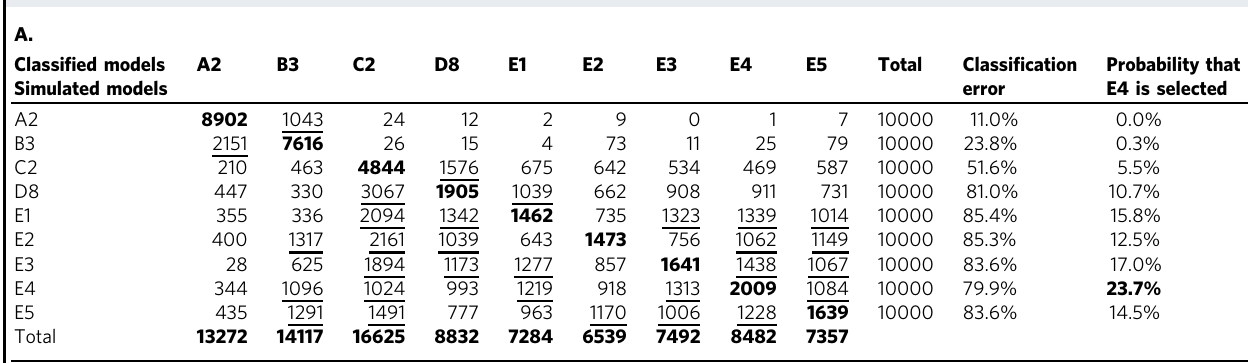
Table 2 . (A) Power to discriminate between alternative demographic models using an “ out-of-bag ” procedure given the parameter model speci fi